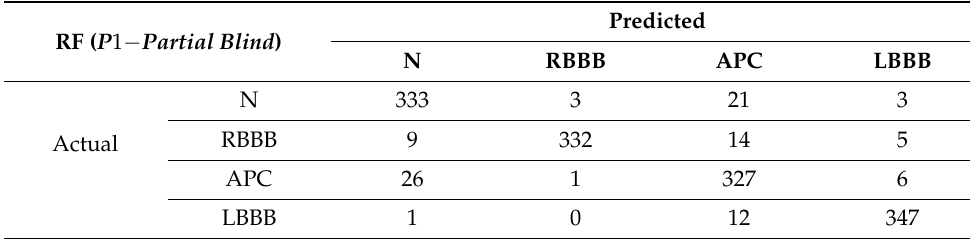
Table 7. Confusion matrix for the RF classifier applied to the P 1 dataset within the partial blind testing protocol (accuracy = 92.99%).